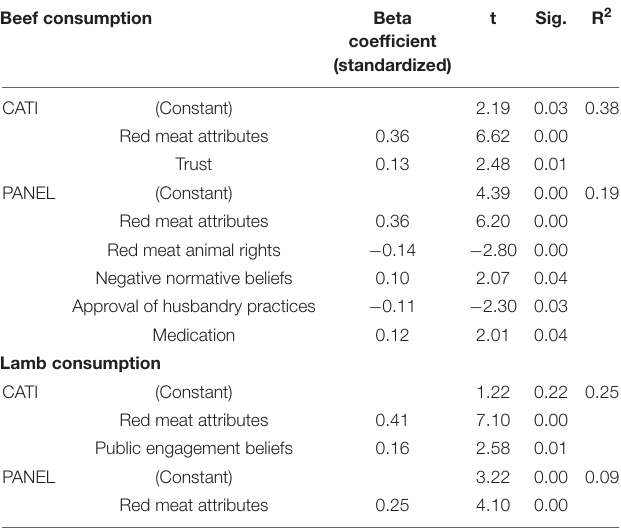
TABLE 11 | Linear regression with beef consumption or lamb consumption as the dependent variable and all composite variables entered listwise as the